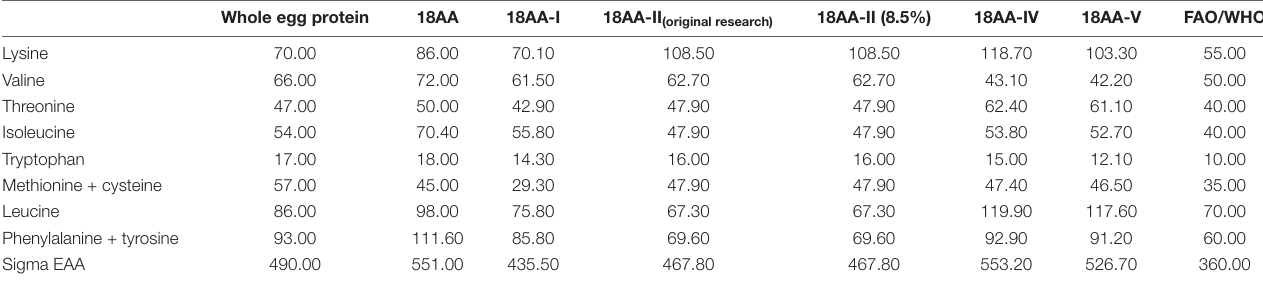
TABLE 3 | EAA of compound amino acids for injection.